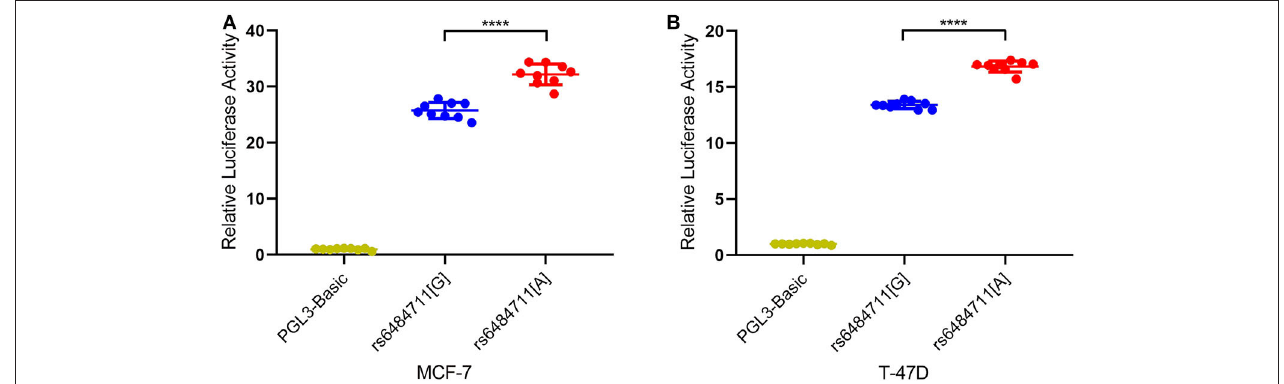
FIGURE 1 | Reporter gene expression driven by different rs6484711 alleles in MCF-7 (A) and T-47D (B) cells. Luciferase activities were shown as fold changes relative to luciferase expression in cells transfected with empty vectors (pGL3-Basic). All constructs were cotransfected with PRL-TK to standardize transfection efficiency. Data shown were the mean ± S.D. from three independent experiments, each had three replicates. **** P < 0.0001.